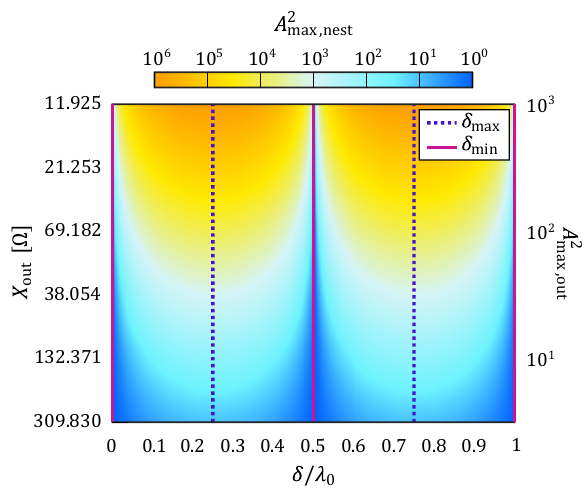
Figure 2: A nested invisible cavity can control the properties of standing waves by simply moving the inner resonator within the outer one. With the proper alignment, the maximum field localized in the inner cavity can = 1 (no standing wave) and a be controlled in the range between A 2 max , nes t = A 4 . The reactances were chosen following maximum of A 2 max , nest max , out = − X , with values that guarantee a field an alternating pattern X in out ≈ 3 . 16 and amplification of the outer cavity in the range between A 2 max , out ≈ A 2 max , out